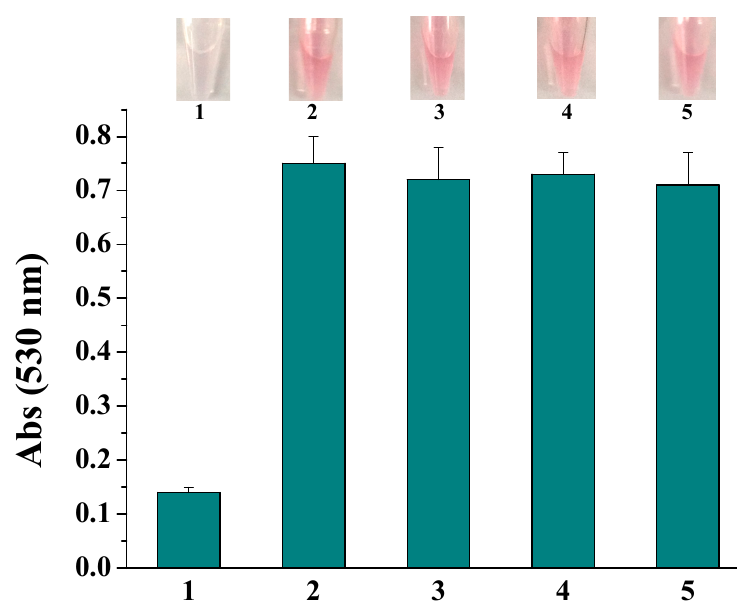
Figure 6. The photographic images and absorption intensity for assays of various proteins (1, PSA; 2, BSA; 3, IgG; 4, albumin; 5, hemoglobin). The final concentration of PSA was 10 ng/mL and that of other proteins is 100 ng/mL.